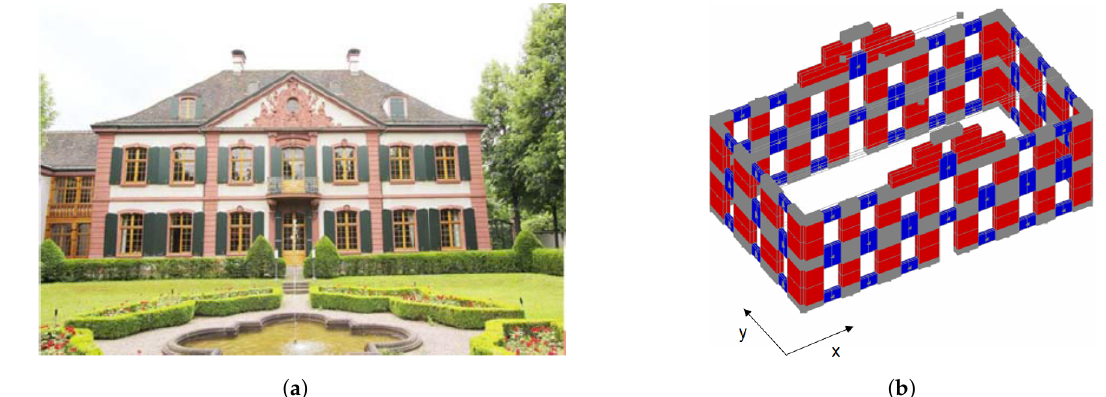
Figure 2. Holsteiner Hof. ( a ) Main façade. ( b ) Numerical model with the coordinate system.